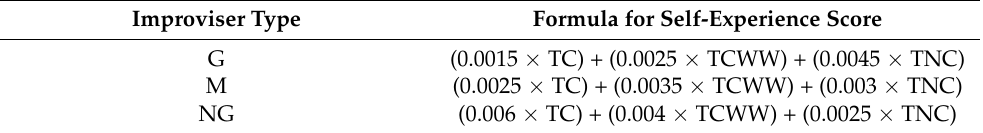
Table 6. Survey results for